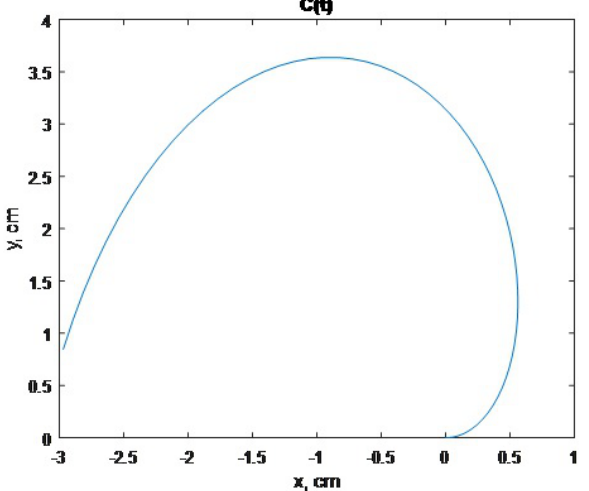
Figure 11. The cylinder motion